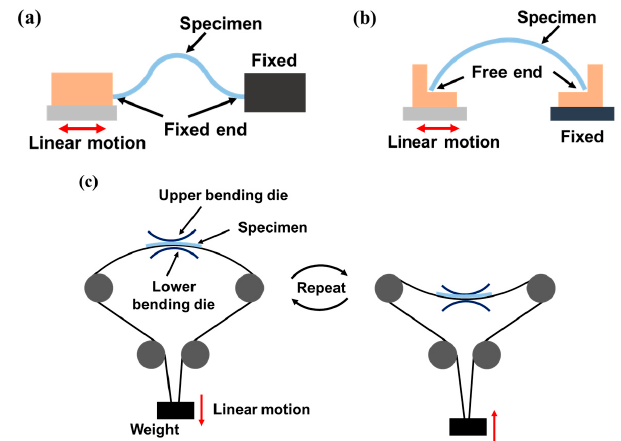
Figure 1. Schematics of conventional bending test methods for flexible electronic devices: ( a ) linear bending test with clamped ends; ( b ) linear bending test with free ends; ( c ) two-sided bending test using contact dies.